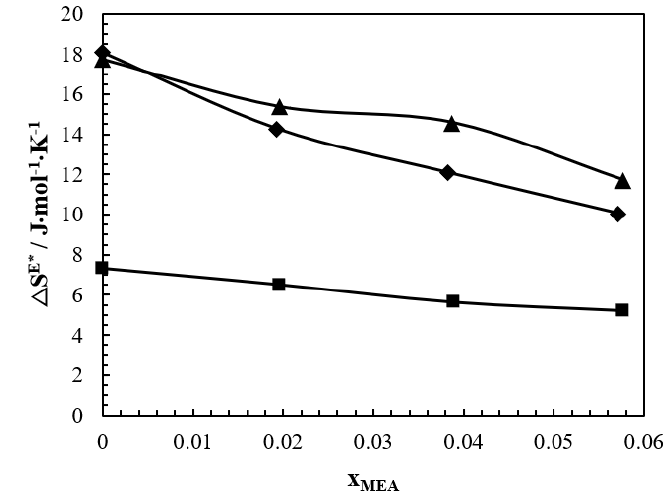
Figure 4. Excess free energy ∆𝐺 𝐸∗ of activation for the viscous flow of “ ◼ ”—MDEA + MEA + H 2 O, “ ◆ ”—DMEA + MEA + H 2 O, and “ ▲ ”—DEEA + MEA + H 2 O at 293.15